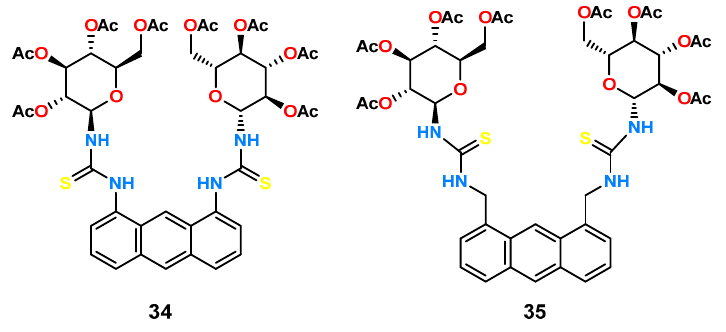
Figure 13. Anthracene receptors 34 and 35 decorated with thiourea glucopyranoses.